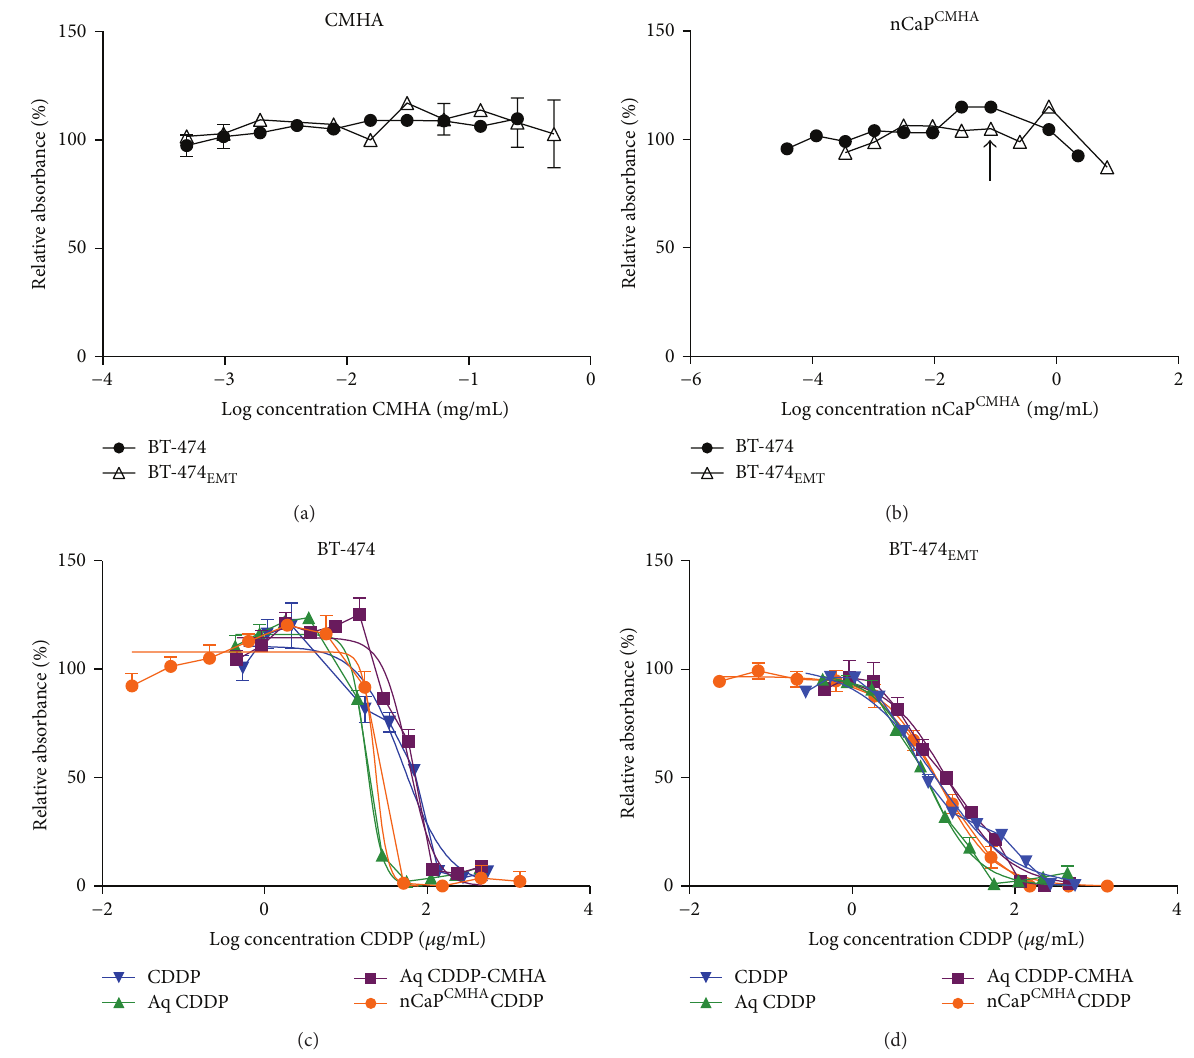
Figure 7: Cytotoxicity examination of CMHA, nCaP CMHA , CDDP, Aq CDDP, Aq CDDP-CMHA and nCaP CMHA CDDP evaluated against BT- cells using an MTS assay. (a) Evaluation of CMHA alone against BT-474 and BT-47 4 cells, showing no cytotoxicity. 474 and BT-47 4 EMT EMT cells, showing no cytotoxicity. (c) Cytotoxicity evaluation using BT-474 (b) Evaluation of nCaP CMHA alone against BT-474 and BT-47 4 EMT (CD44 − ) cells. CDDP, Aq CDDP, and Aq CDDP reacted with CMHA (Aq CDDP-CMHA), and nCaP CMHA CDDP curves are plotted. (d) (CD44 + ) cells. CDDP, Aq CDDP, and Aq CDDP reacted with CMHA (Aq CDDP-CMHA), and Cytotoxicity evaluation using BT-47 4 EMT nCaP CMHA CDDP curves are